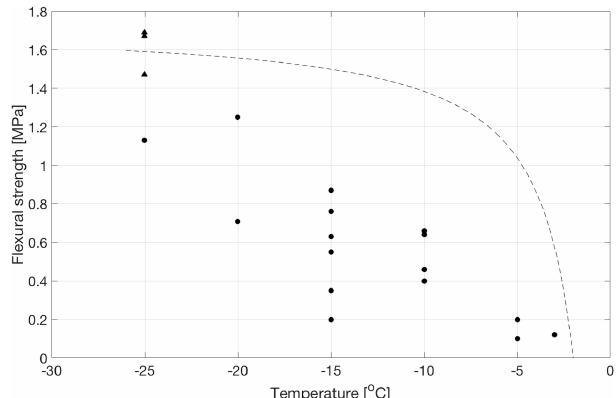
Figure 2. Flexural strength as a function of freezing time for bonded ice prepared from salt water of 35ppt salinity at − 10 ◦ C (in black) and from salt water of 12ppt salinity at − 3 ◦ C (in red).